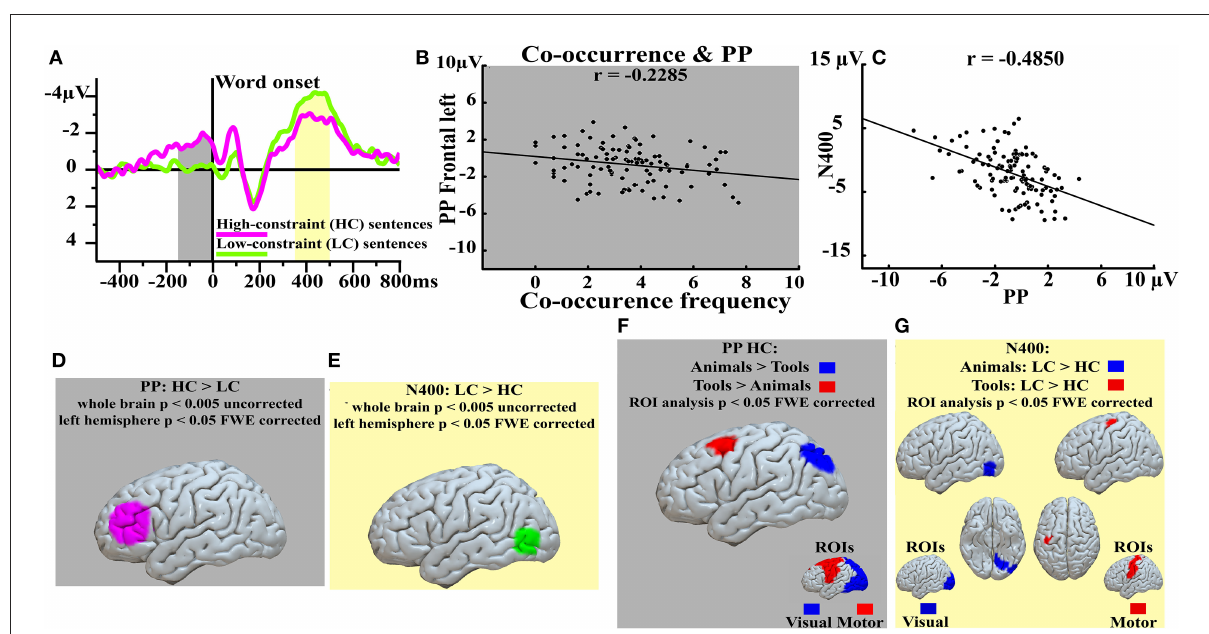
FIGURE1 Event-related potentials (ERPs) and source analysis results. Top left (A) ERPs elicited by predictable (HC, magenta) and unpredictable (LC, green) sentences at both the pre- (PP, gray window) and post-stimulus (N400, yellow window) latencies. Top central (B) significant correlation between the corpus-based, co-occurrence frequency (x-axis) and the PP (y-axis) responses at left-frontal electrodes. Top right (C) negative correlation between the PP (x-axis) and the N400 (y-axis) responses recorded at centro-occipital electrodes. Bottom left (D) and bottom central (E) sources contrasts at the PP latency [HC > LC, (D) ] and at the N400 latency [LC > HC, (E) ]. Sub-panel (F) shows the contrasts of the source estimations (Region of Interest, ROIs, analysis; the ROIs are depicted at the bottom right of this sub-panel) HC: Tools > Animals (red) and HC: Animals > Tools (blue) at the pre-stimulus, PP, latency; whereas sub-panel (G) shows the contrasts of the source estimations (Region of Interest, ROIs, analysis; the ROIs are depicted at the bottom right of this sub-panel) Tools: LC > HC (red) and Animals: LC > HC (blue) at the post-stimulus, N400, latency. Modified from (Grisoni et al.,